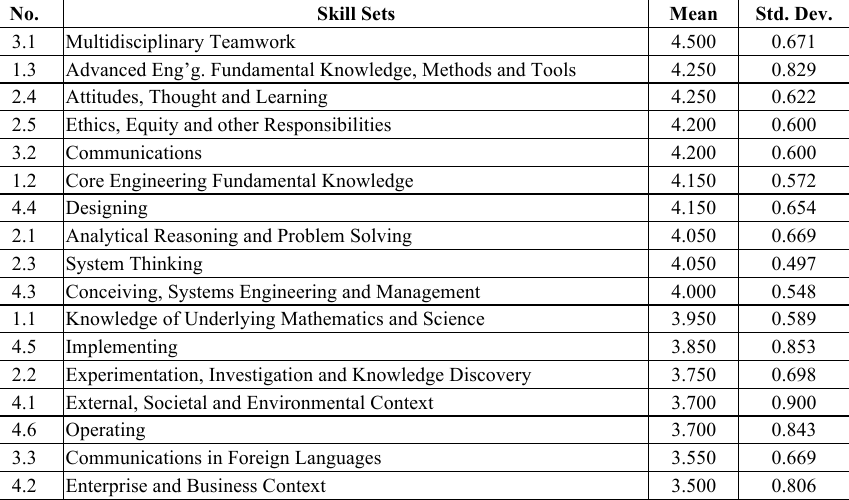
Table 5. Result of Industry Needs